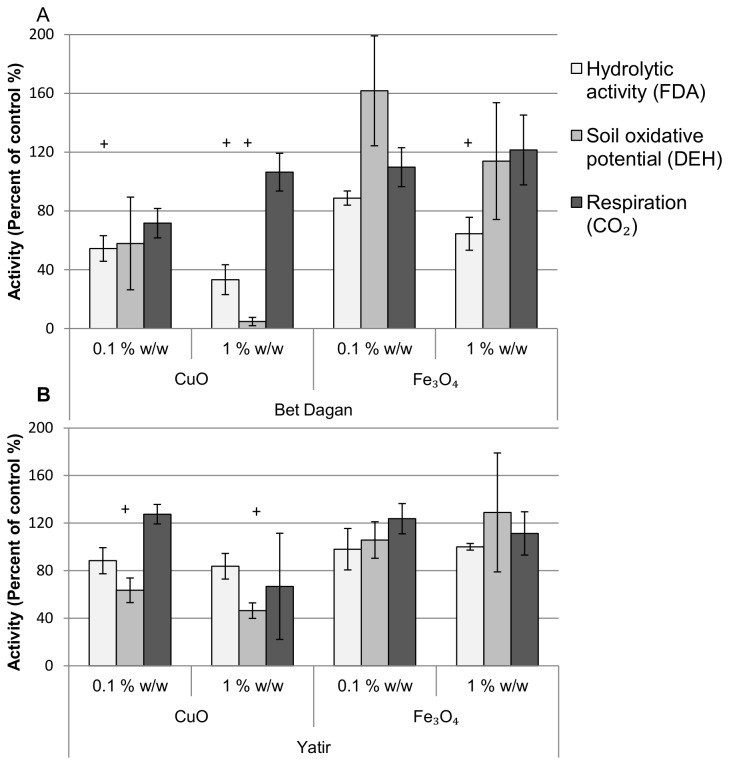
Effect of MO-ENPs on microbial activities in soil.Enzymatic assays of Bet-Dagan (A) and Yatir (B) soil exposed to two MO-ENPs, CuO and Fe3O4, in two concentrations, 0.1 and 1% w/w. White: FDA assay(n=5); light gray: DEH assay(n=5); dark gray: CO2 emission(n=3). All results are described as the percent of activity relative to the average activity of unexposed controls. +, treatments that differ significantly from unexposed control (p<0.05).